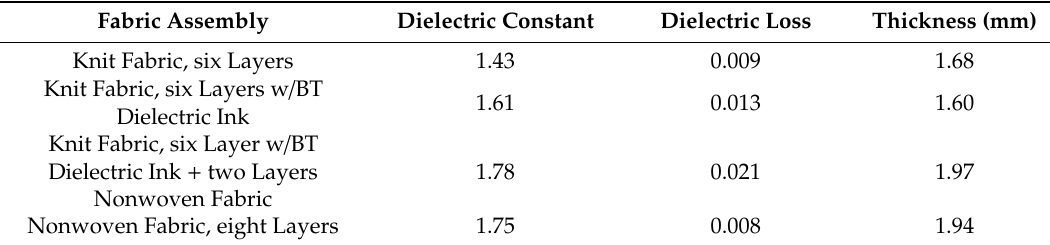
Table 2. Fabric dielectric properties.